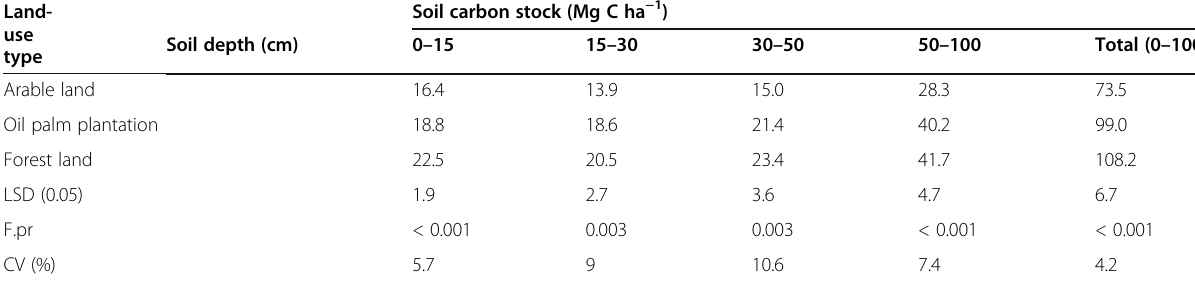
Table 4 Soil organic carbon stock in the land-use systems Land- use